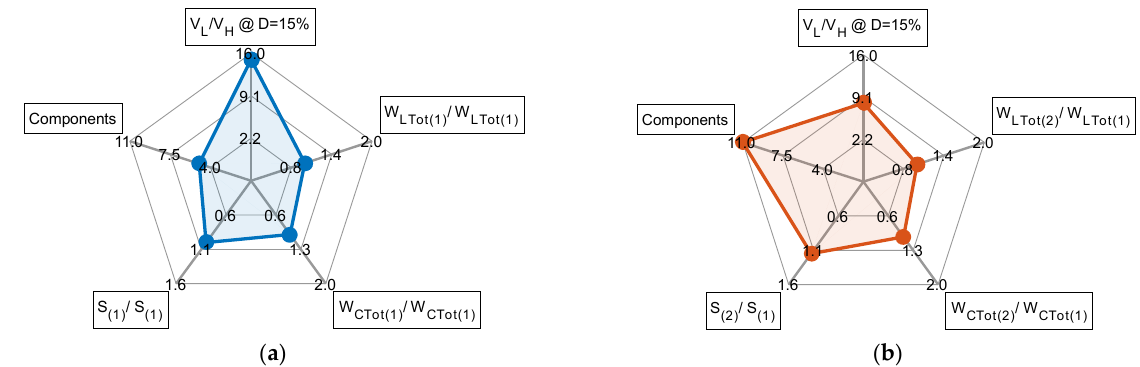
Figure 10. Radar chart with 5 axes: voltage conversion ratio (@D = 15%); number of components; total active switch stress; mean inductor energy; mean capacitor energy. ( a ) Chart of the conventional buck–boost converter. ( b ) Chart of the BHSC.